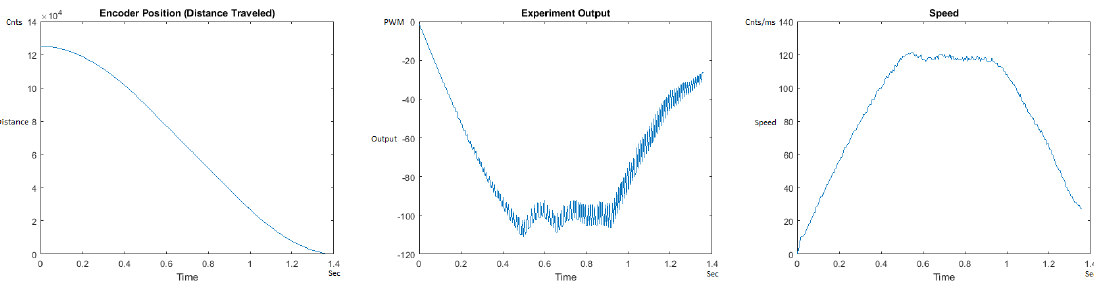
Figure 31. Encoder position, output and speed plots for PID++ DOWN operation— Vmax 120 cnts/ms, Adesired 0.055 cnts/ms 2 —10 g.